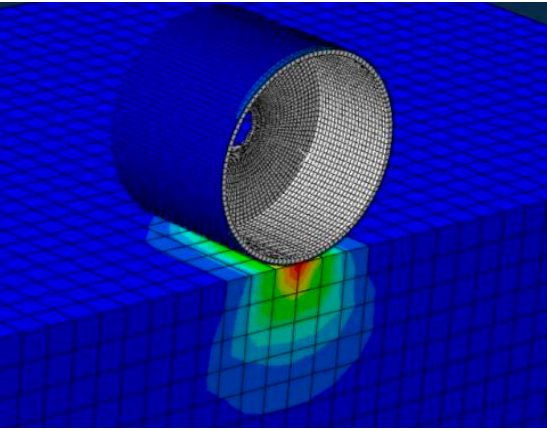
Figure 4. Stress nephogram of finite element simulation of “machine-pavement” system during jumping.